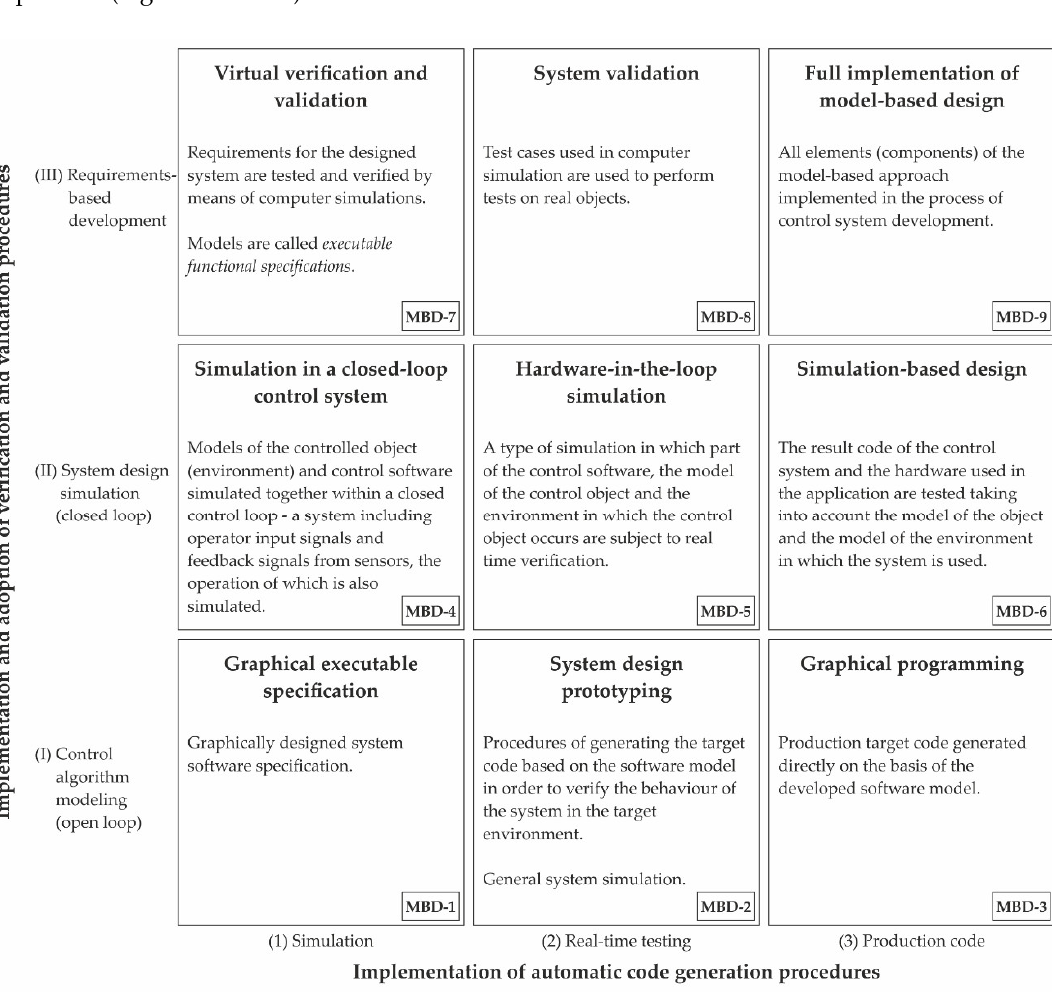
Figure 1. The nine-box model for implementation of Model-Based Design concepts [7].